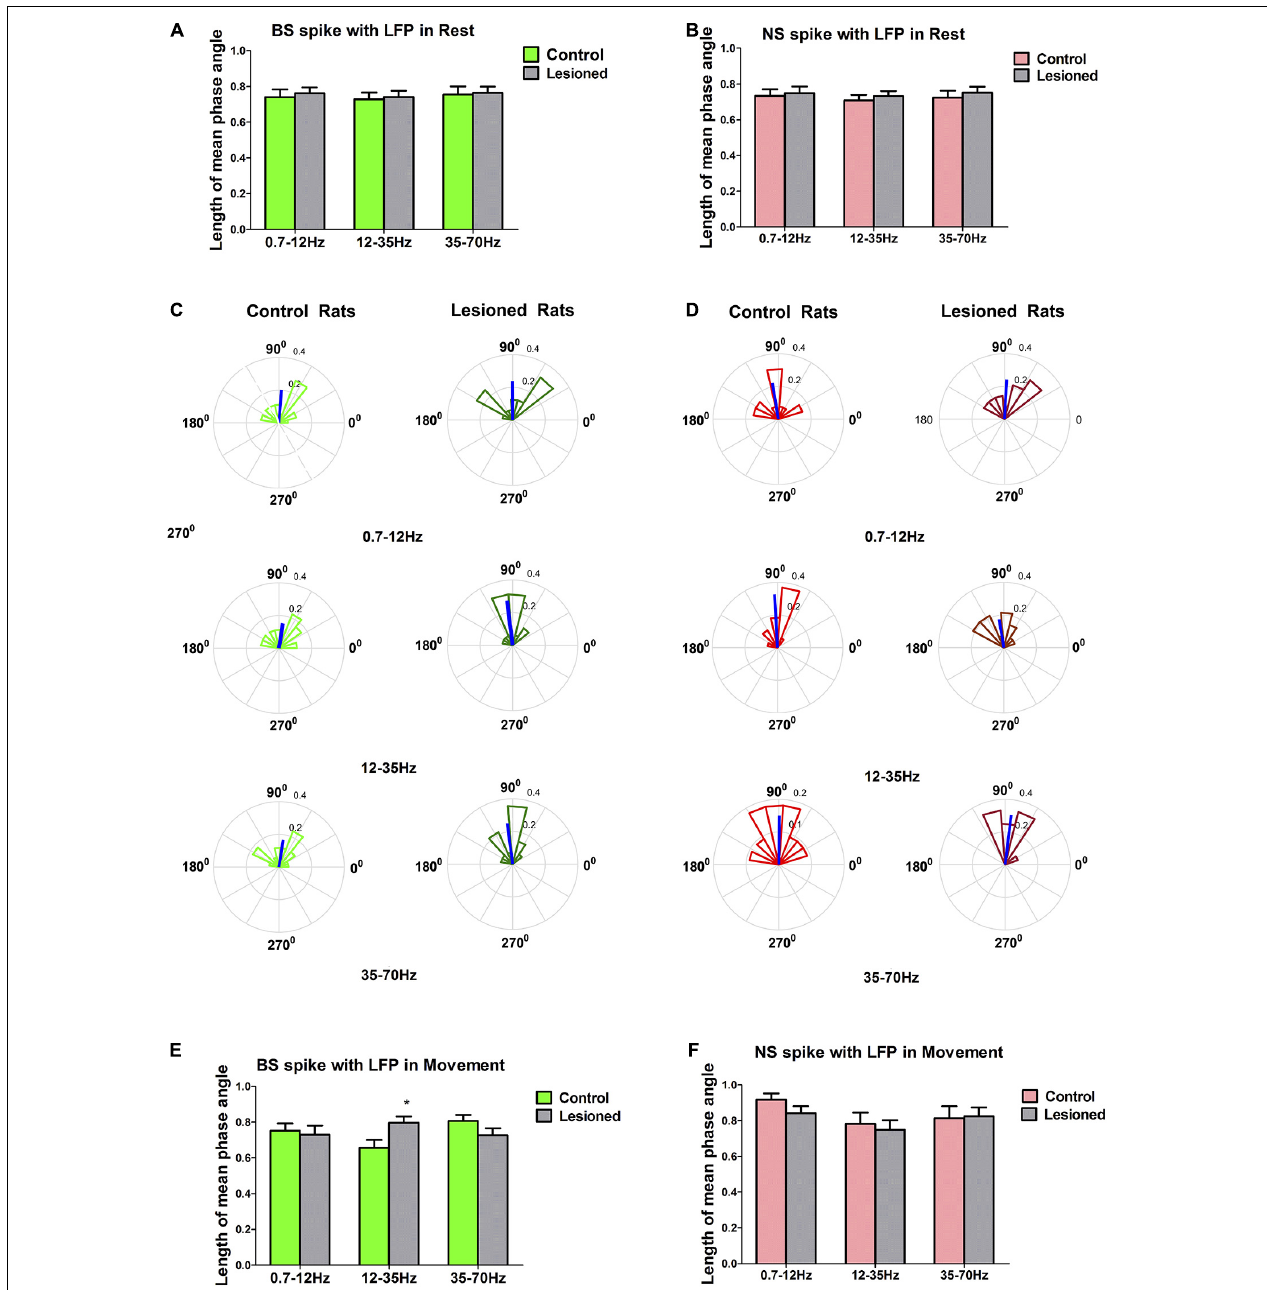
FIGURE 10 | Characteristics of the phase locking between the BS or NS neuron M1 spike activities with respect to LFP in dopamine-intact and 6-OHDA-treated rats. During resting epoch, the phase locking levels represented by mean vector length between BS ( n = 31 neurons in control, 27 neurons in 6-OHDA-treated) and LFP activity at the 0.7–12, 12–35, and 35–70 Hz does not change significantly following dopamine cell lesion (A) , nor does it change in the NS ( n = 26 neurons in control, 24 in 6-OHDA-treated) (B) . During the movement epoch, phase circular plots show the distributions of phase relationships between BS or NS spikes and cortical LFPs at the 0.7–12, 12–35, and 35–70 Hz. Thick blue lines radiating from the center indicate a measure of the strength of concentration of the distribution of the mean phase angle of all BS ( n = 22 neurons, 8 in 6-OHDA-treated rats; n = 27 neurons, 13 in control rats) or NS ( n = 23 neurons, 7 in 6-OHDA-treated rats; n = 21 neurons 8 in control rats) spikes in that group. The mean angle of phase locking and greater vector lengths indicate lower variance in the distribution around the mean phase angle for each neuron. Note that BS neurons (dark green) in 6-OHDA-treated rats had significantly longer vectors and thus were more phase locked to LFP activities at 12–35 Hz than those neurons (light green) in control rats (* p < 0.05 Mann–Whitney U test) (C,E) . NS neurons (light red) in control rats did not significantly change in mean vector length compared to that of neurons (dark red) in 6-OHDA-treated rats at 0.7–12, 12–35, and 35–70 Hz (D,F) .